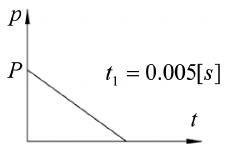
Fig. 8. Loading time history – triangular pulse load.